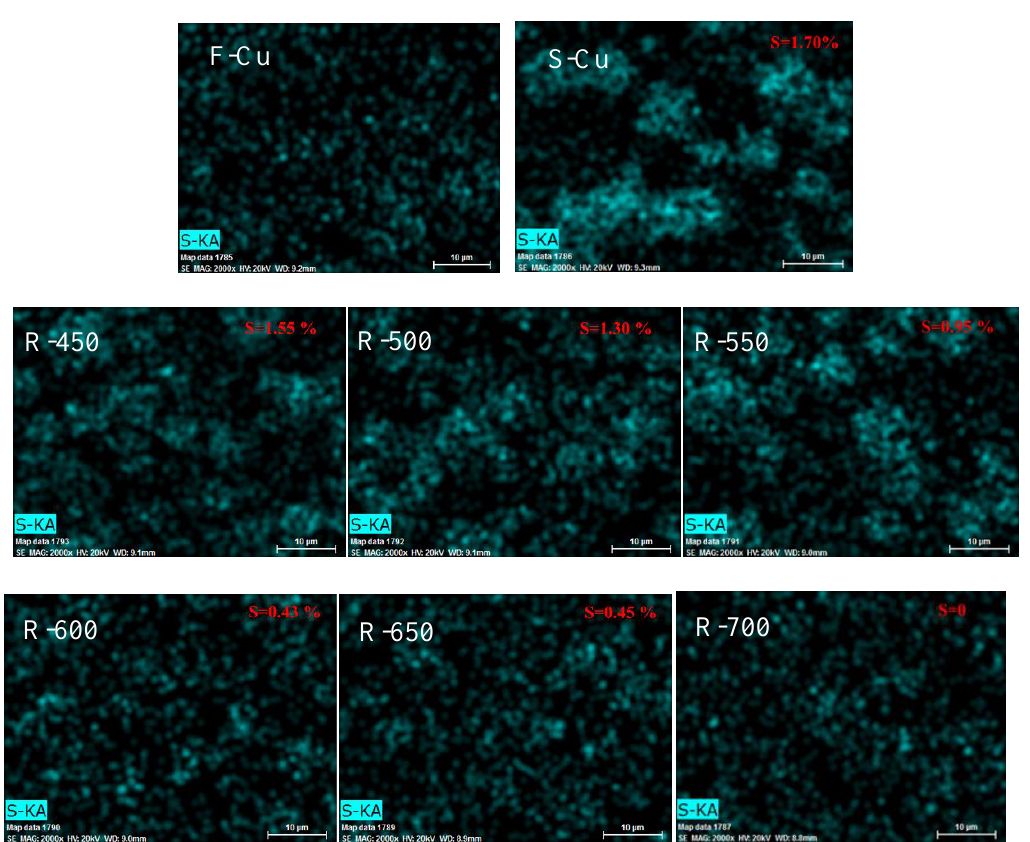
Figure 4. The elemental mapping and EDX results of Cu-SSZ-13 catalysts in fresh, sulfated and regenerated states.